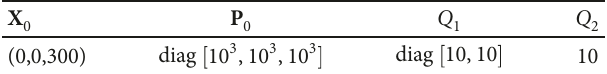
Table 1: Simulation parameters.